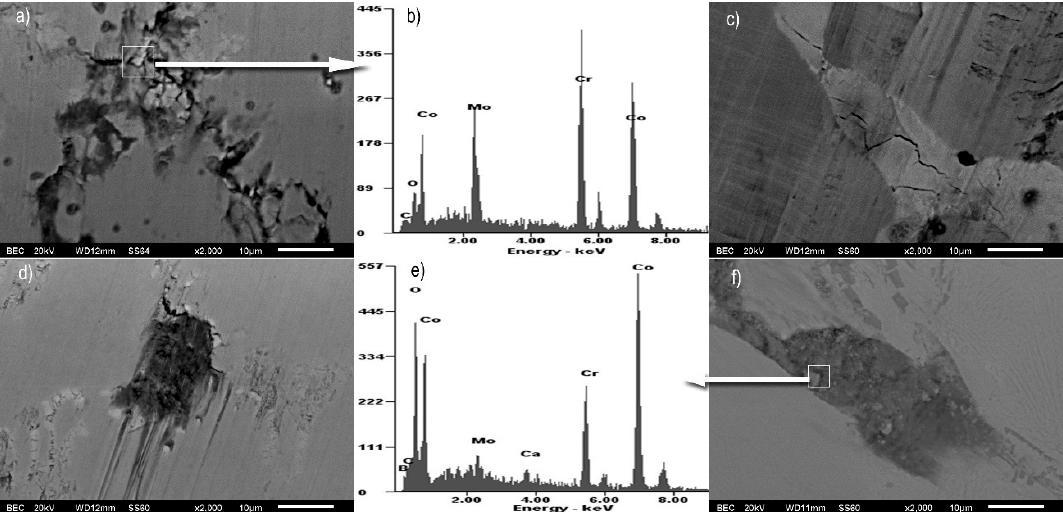
Figure 7. Fracture and detachment of secondary phases. ( a ) 0B-AC 12 km, ( b ) EDS in 0B-AC, ( c ) 0.06B-AC 4 km, ( d ) 1B-AC 8 km, ( e ) EDS in 1B-AC, ( f ) 1B-HT 12 km.